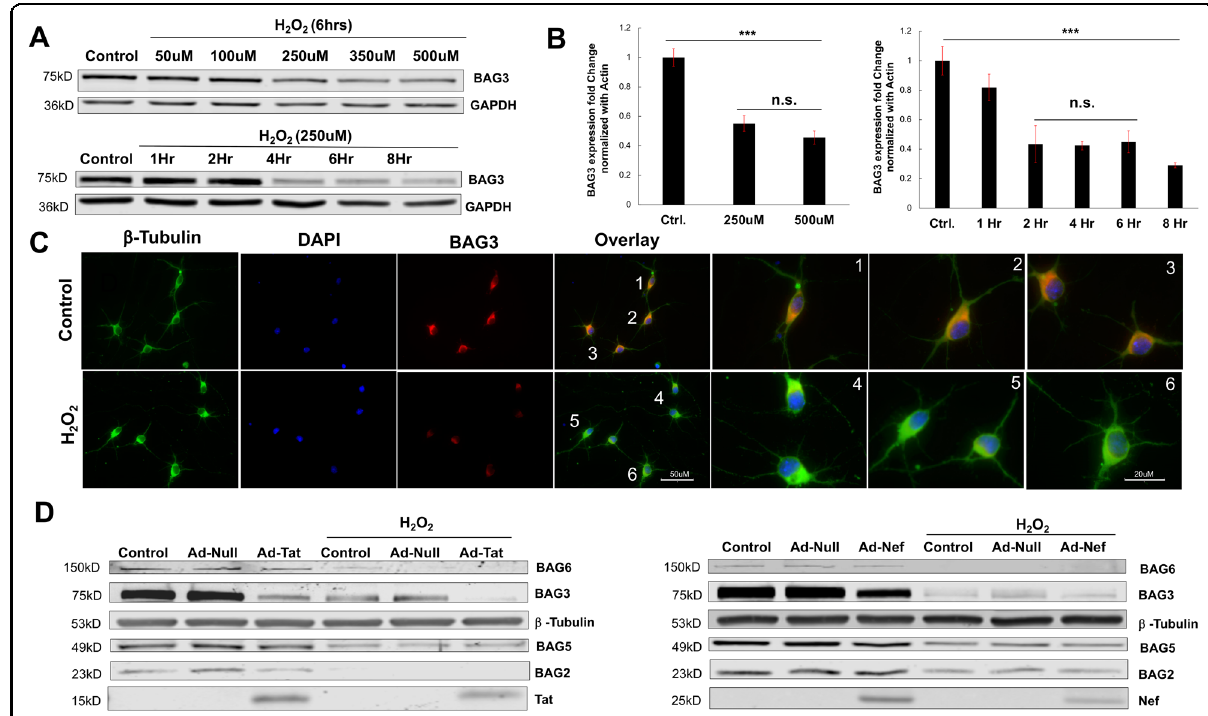
Fig. 2 H 2 O 2 induces BAG3 reduction. A Immunoblot results indicated H 2 O 2 treatment caused time and dosage-dependent decreases in neuronal BAG3. B qPCR demonstrated H 2 O 2 treatment causes signi fi cant decreases in neuronal BAG3 RNA. C In addition to validating H 2 O 2 -induced reductions in BAG3 protein, immunocytochemistry suggested neurons exposed to H 2 O 2 treatment may develop minor dystrophies in their branching